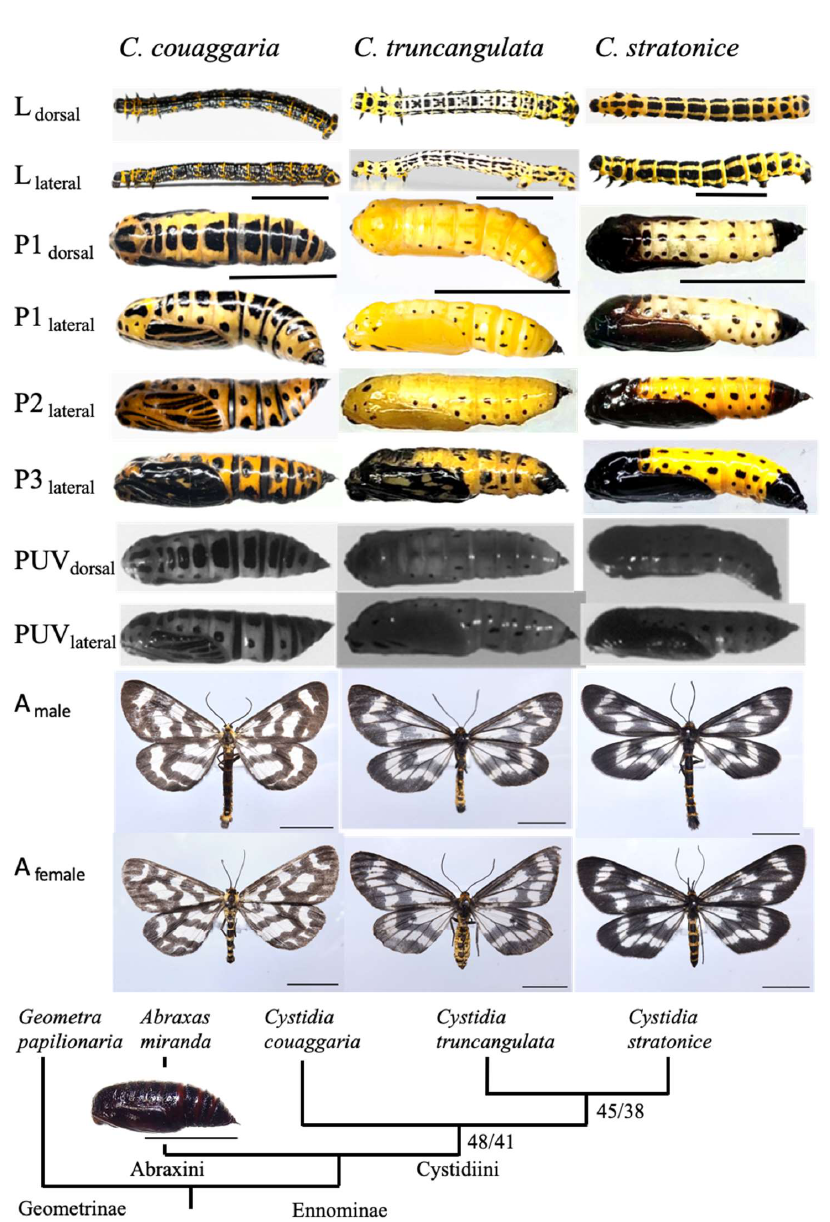
Figure 1. Larvae (L), pupae (P), and adults (A) of the three species of Cystidia moths; C. couaggaria , C. truncangulata , and C. stratonice . Each photograph shows the dorsal or lateral view under visible and ultraviolet (UV) light. In pupal stage, P1–P3 shows the pupal color patterns in the day of pupation, 6th or 7th day since pupation, and 1 day before adult emergence. The DNA barcoding result is drawn for three species of Cystidia and the outgroup Abraxas miranda (JN087399) belonging to the tribe Abraxini of the subfamily Ennominae and Geometra papilionaria (GU655815) belonging to the subfamily Geometrinae. The numerals near the branches present % probabilities in the neighbor- joining/maximum likelihood methods. Scale bars show 10